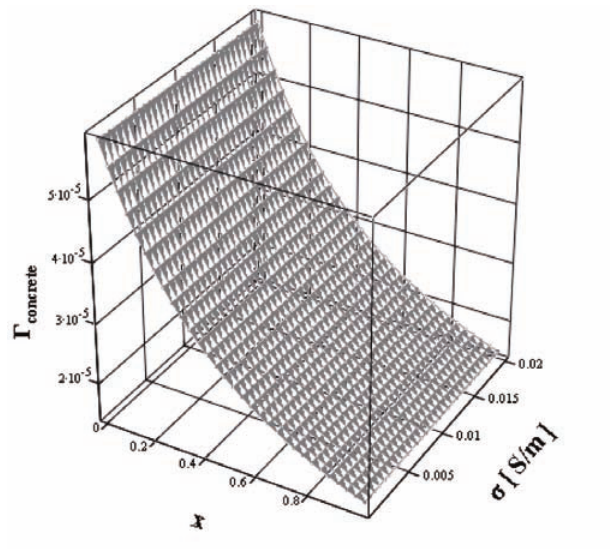
Figure 5. Ratio C = C / C between the first member C 1 2 of Equation (B.8), plotted as a function C ( x , v ) of both the member C 2 height/dimension ratio x = h / L and the electrical conductivity v , with the quadrupole probe designed in the linear Wenner configuration and in capacitive contact on a selected concrete of dielectric permittivity f